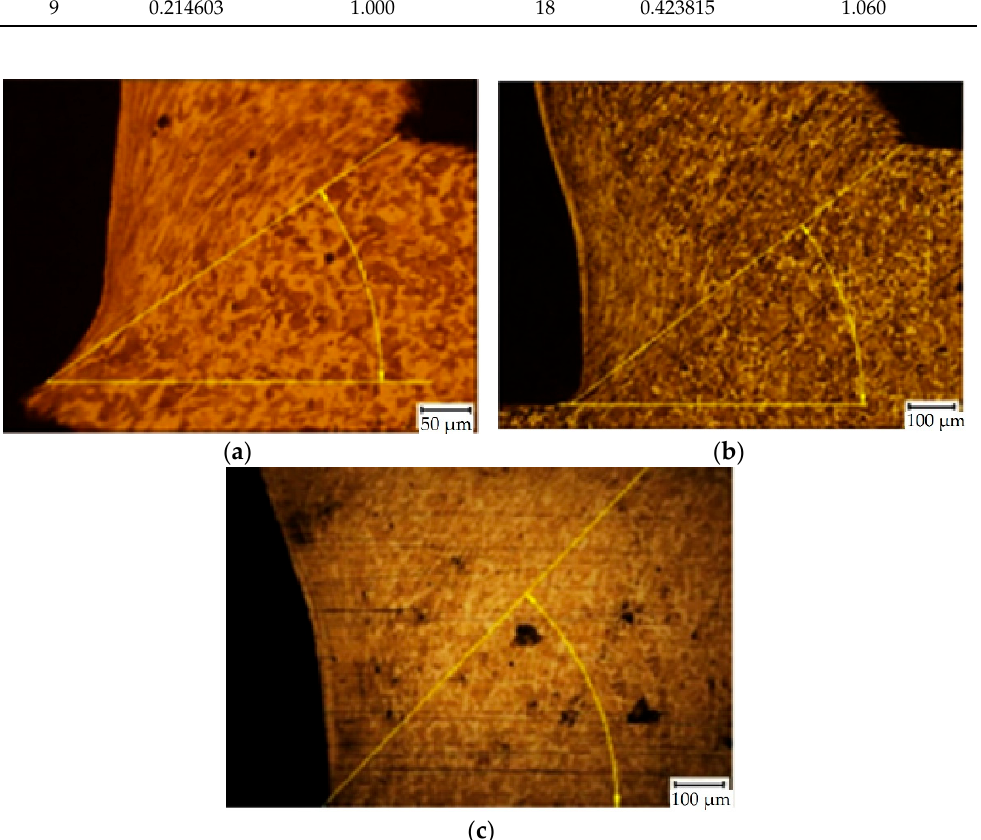
Figure 8. Examples of SEM micrographs of the cutting zone (C45 medium carbon steel, v c = 180 m/min): ( a ) specimen no. 7 ( f = 0.2 mm), φ = 37 ◦ ; ( b ) specimen no. 8 ( f = 0.4 mm), φ = 39 ◦ ; ( c ) specimen no. 9 ( f = 0.6 mm), φ = 49 ◦